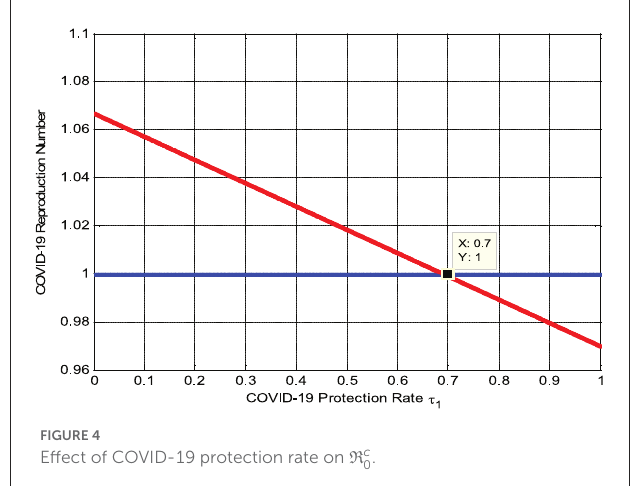
FIGURE6 Impact of treatment rate ε on I cs .